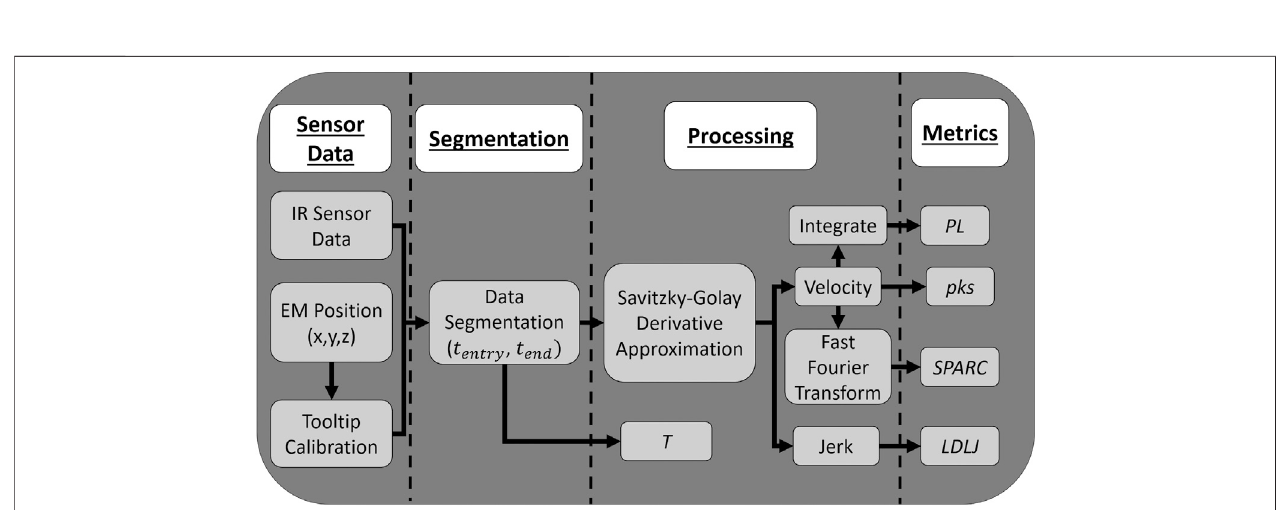
FIGURE 4 | Flowchart presenting how data are collected and processed and how the process metrics are calculated.